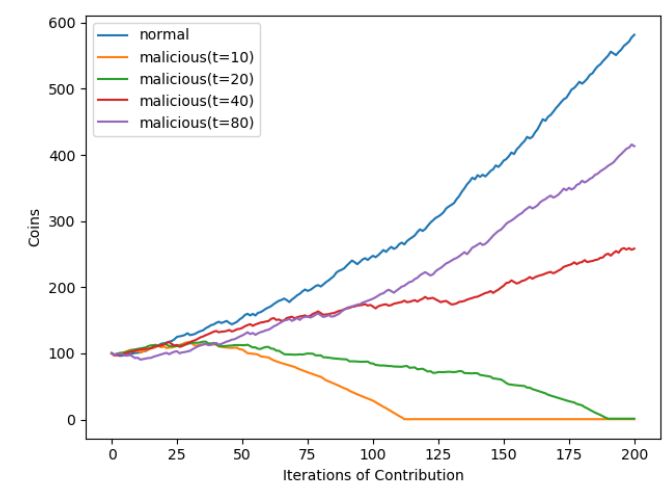
Figure 7. Changes of cryptocurrencies held by each contributor and attacker ( p = 8).